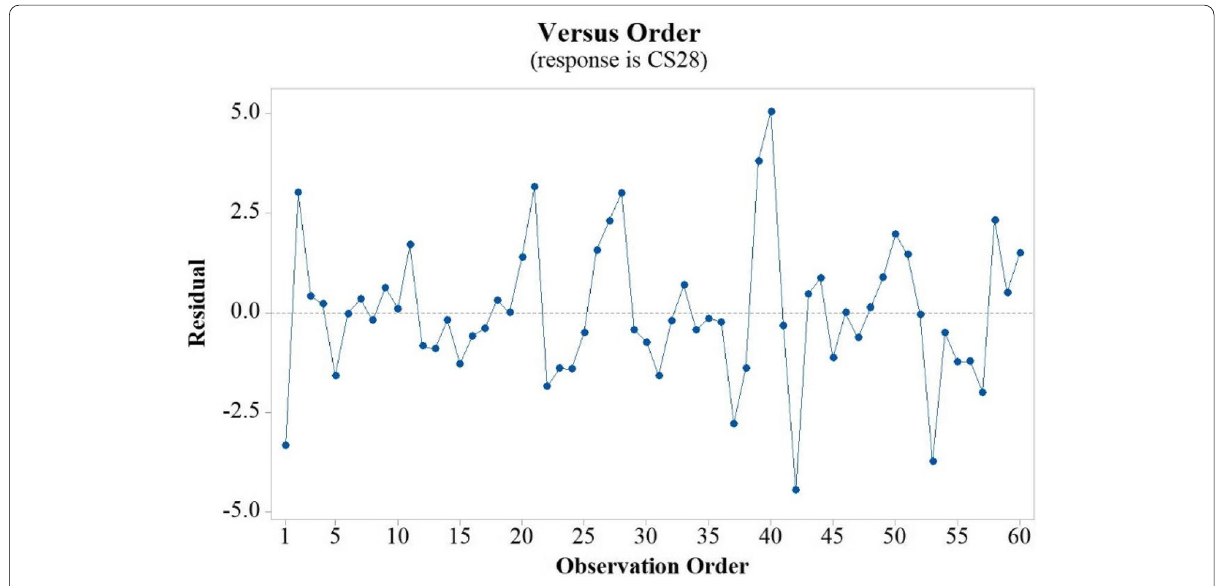
Fig. 6 Residual versus Order Plot of PET-FA expression